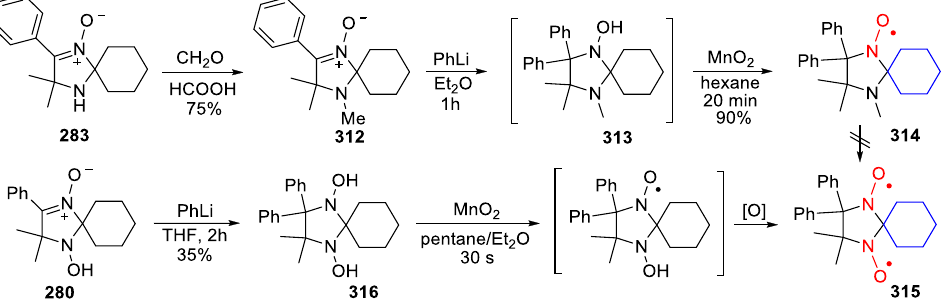
Figure 12. An EPR spectrum of SNR 323 .